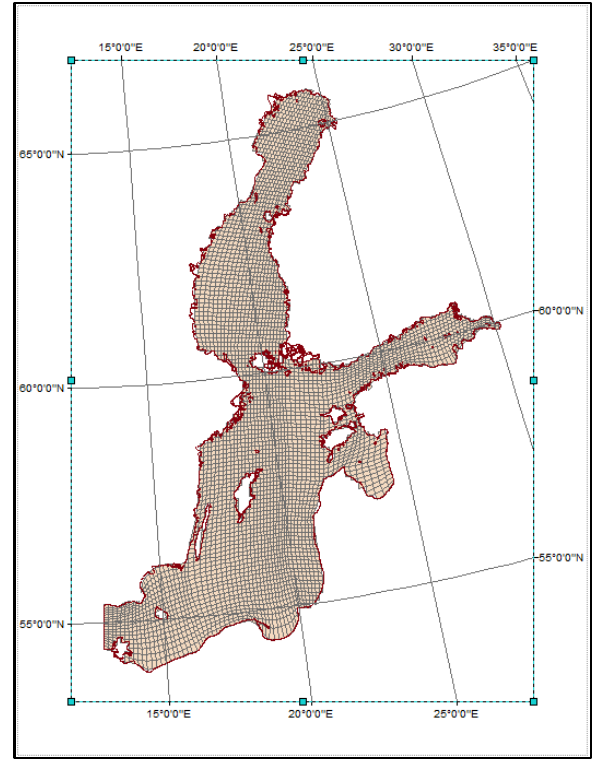
Figure 4. The Baltic Sea numerical model grid.